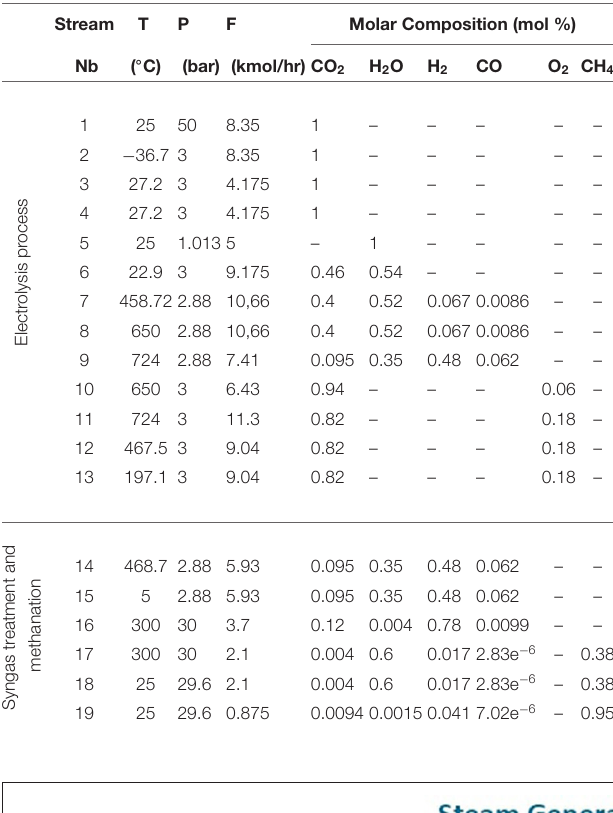
TABLE 1 | Summary of the thermodynamic and chemical properties of the process streams.